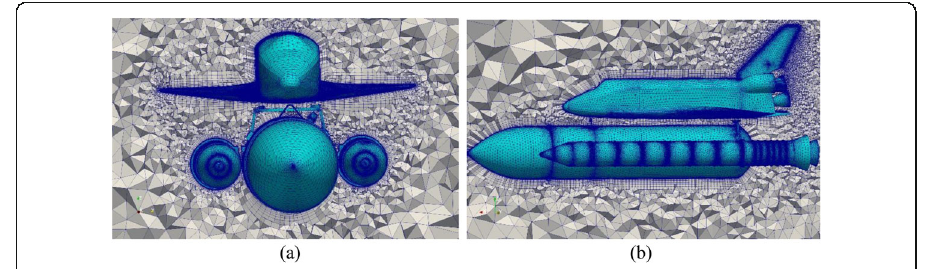
Fig. 9 Cut-out views of the hybrid mesh of the space shuttle model: ( a ) Front view; ( b ) Side view